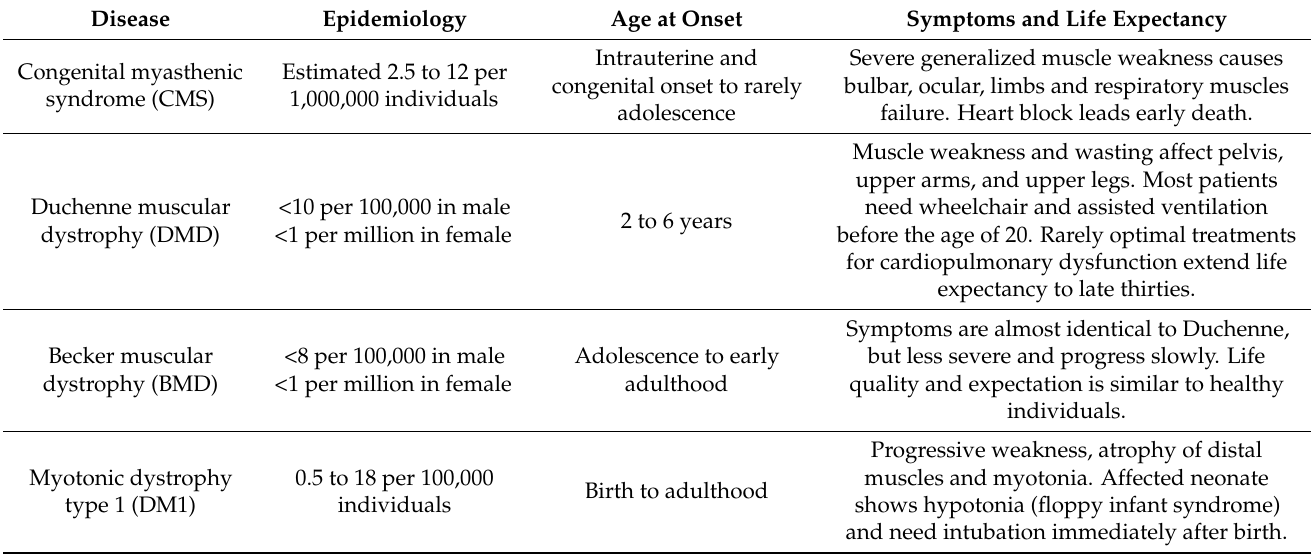
Table 1. Summary of the epidemiological and clinical features of neuromuscular diseases.